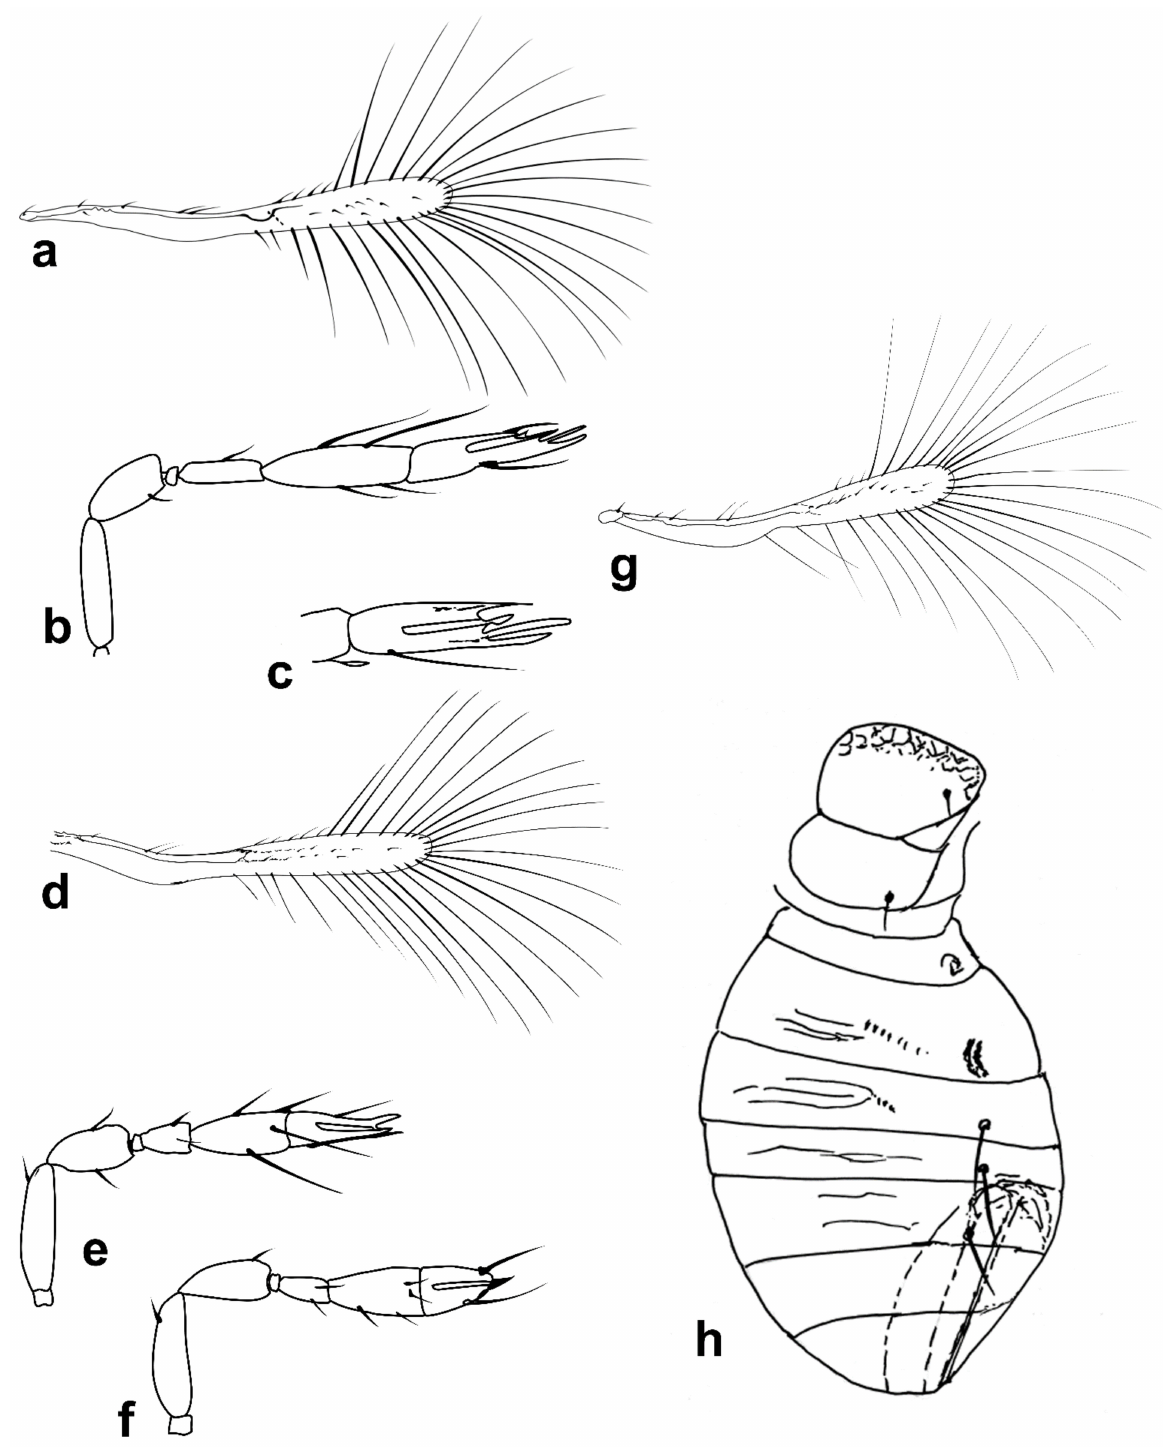
Figure 5. Line drawings of Megaphragma species: ( a ) M. giraulti , female fore wing (Holotype); ( b ) M. kinuthiae , female antenna; ( c ) M. kinuthiae , female antenna (detail); ( d ) M. kinuthiae , female fore wing; ( e ) M. longiciliatum , female antenna; ( f ) M. longiciliatum , male antenna; ( g ) M. longiciliatum , female fore wing; ( h ) M. longiciliatum , female dorsal meso-and